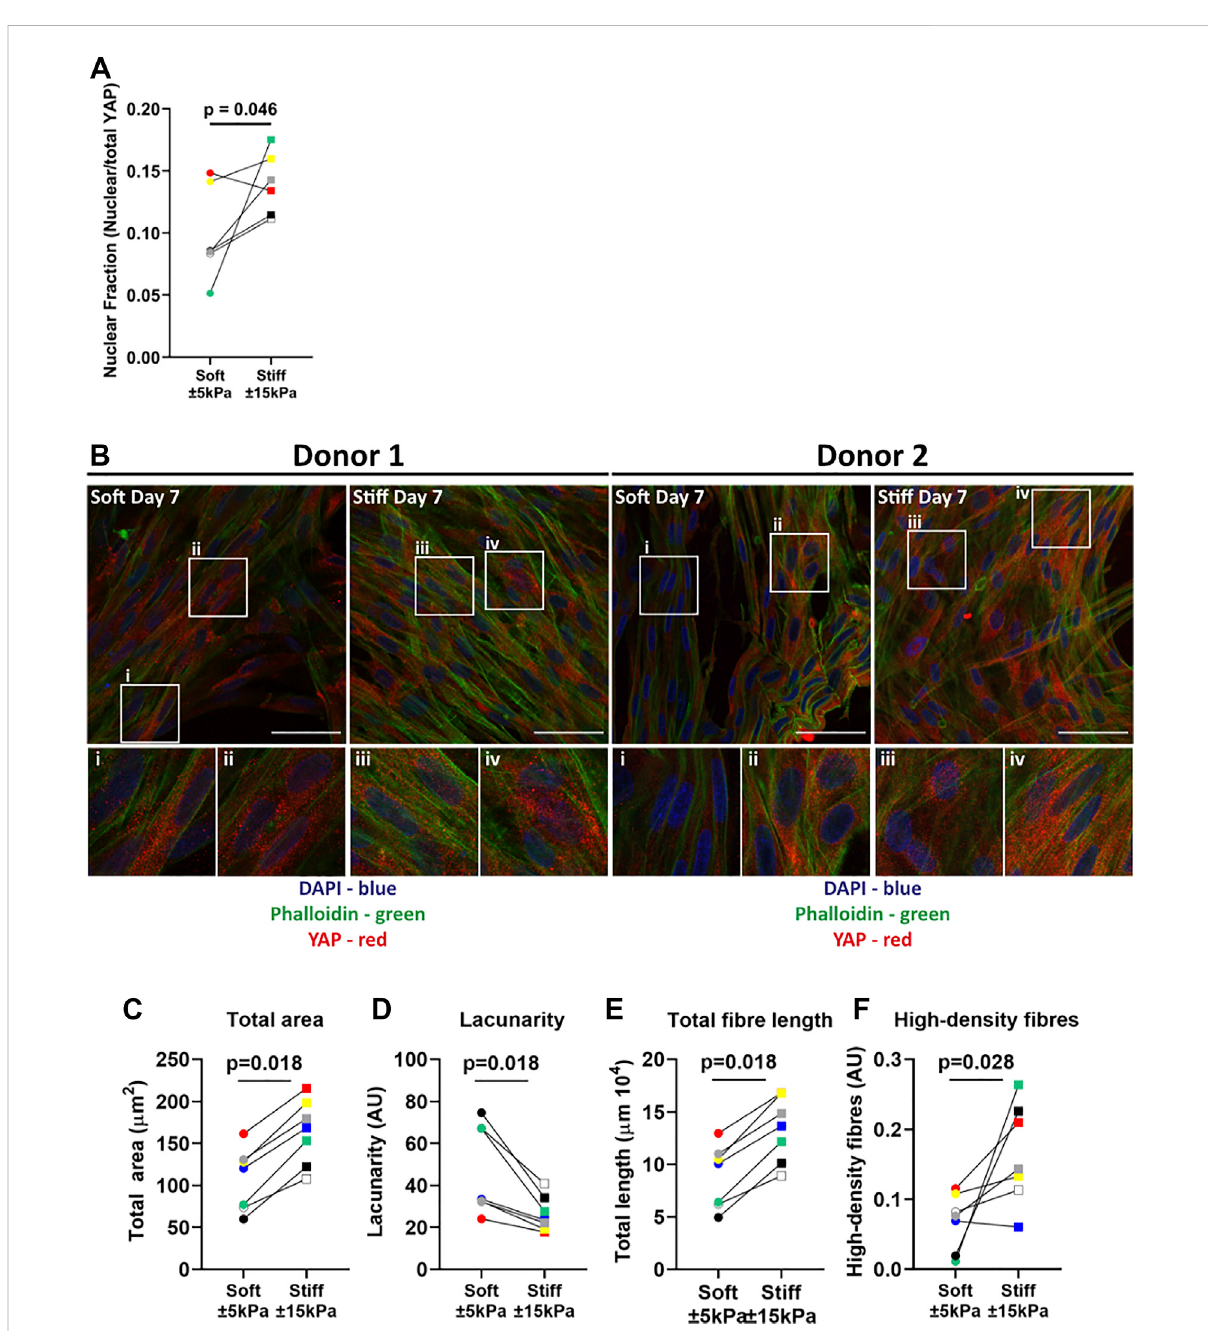
FIGURE 3 YAP translocation and F-actin stress fi bre formation in primary human lung fi broblasts on soft (3.94 ± 0.87 kPa) and stiff (11.34 ± 3.82 kPa) hydrogels. Hydrogelsafter7 daysofculturewere fi xedand fi broblastswerestainedforYAPandF-actin. (A) Quanti fi cationofYAPnuclearfraction (B) representative fl uorescent images of DAPI (Blue), YAP (Red) and F-actin (green). i-iv) White boxes show the region of interest that is magni fi ed. TWOMBLI analyses of phalloidin stained fi broblasts showing total area (C) , lacunarity (D) , fi bre length (E) and high-density fi bre networks (F) (calculated using the high-density matrix algorithm). Images are representative of responses seen in 7 unique donors. ( n = 6 – 7) Scale bar = 50 µm. Each donor has a different unique colour (blue, red, yellow, green, black, white, and